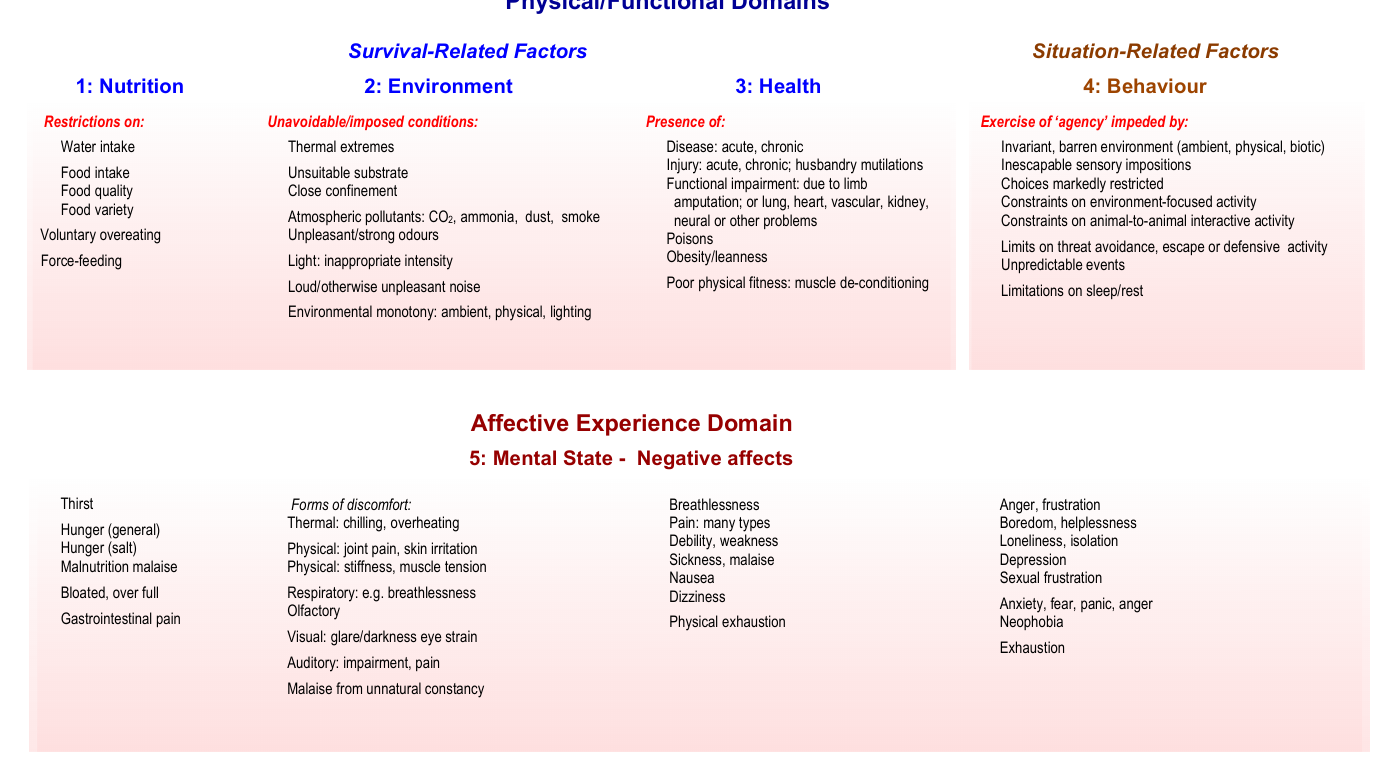
Figure 1. A version of the Five Domains Model adapted from the most recent one [49,53] by removing all reference to welfare-enhancing factors and associated affects in order to make it more directly relevant to formulating expert opinions concerned with ill-treatment. The examples provided for the physical/functional Domains 1 to 3, labelled “Nutrition”, “Environment”, and “Health”, are intended to direct attention towards mainly internal survival-related factors , and those provided for Domain 4, labelled “Behaviour”, focus attention largely on external situation-related factors that affect the animal’s perception of its external circumstances. For each of Domains 1 to 4, examples of negative factors are provided and are aligned with inferred affective experiences, assigned to Domain 5, labelled “Mental State”. Note that an animal exercises “agency” (Domain 4: “Behaviour”) when it engages in voluntary, self-generated, and goal-directed behaviours [11,84]. A detailed explanation of how to operate the Model is available for downloading at no cost from Animals [53].